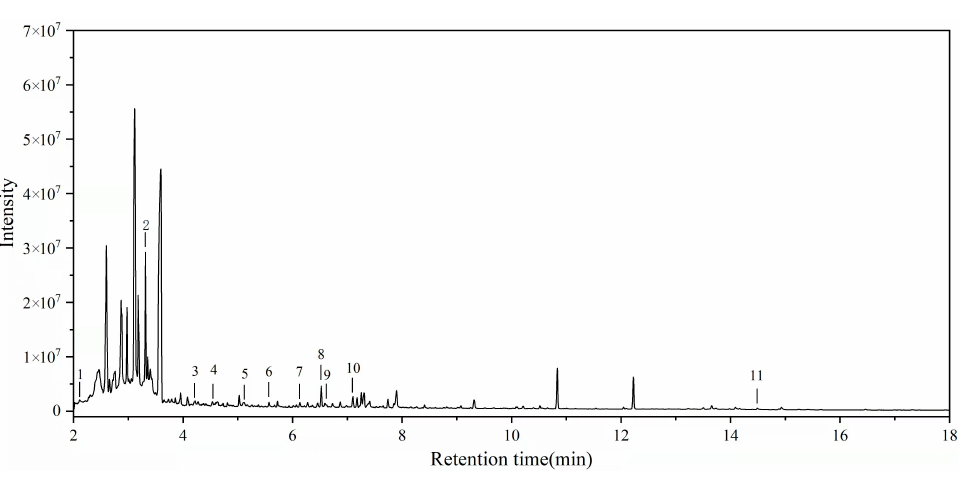
Figure 8. Py-GC/MS chromatogram of the sample. Table 3. The compounds identified by total ion chromatography obtained by Py-GC/MS.